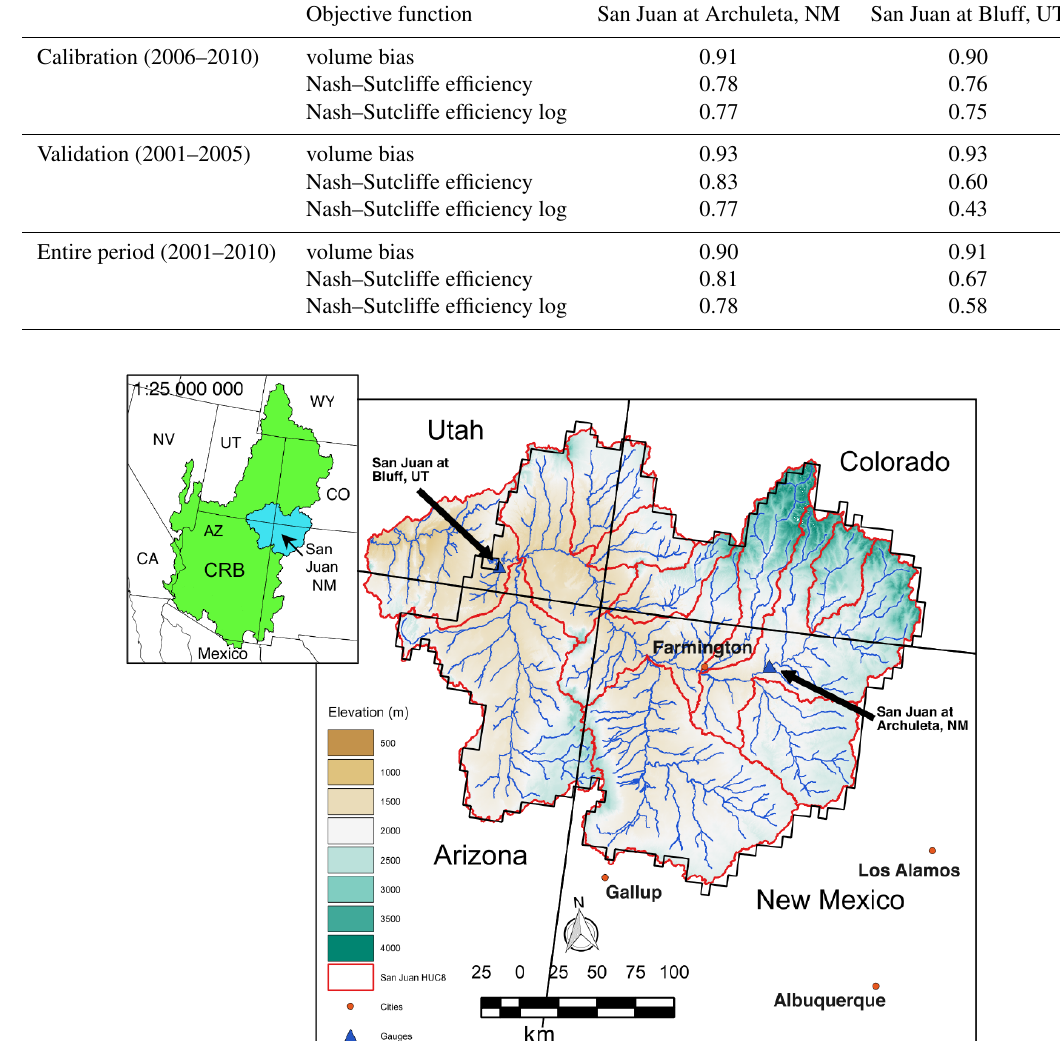
Figure 1. San Juan River basin (61560km 2 ) in the Colorado River watershed (634150km 2 , inset), one of the most important water resources in the western USA. The San Juan River basin (outline of HUC8 watersheds shown in red) spans the Four Corners region (CO, UT, AZ and NM) of the USA, and supports multiple energy and water projects. Naturalized flow gauge sites (USBR) at San Juan at Bluff, UT and San Juan at Archuleta, NM are shown with closed blue